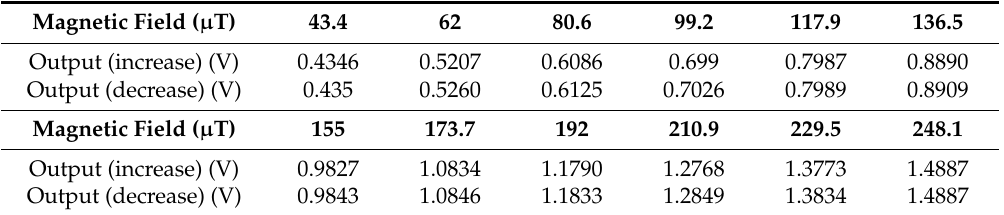
Table 2. The hysteretic characteristic of GMR sensor in an external magnetic field from 43 µ T to 248 µ T.